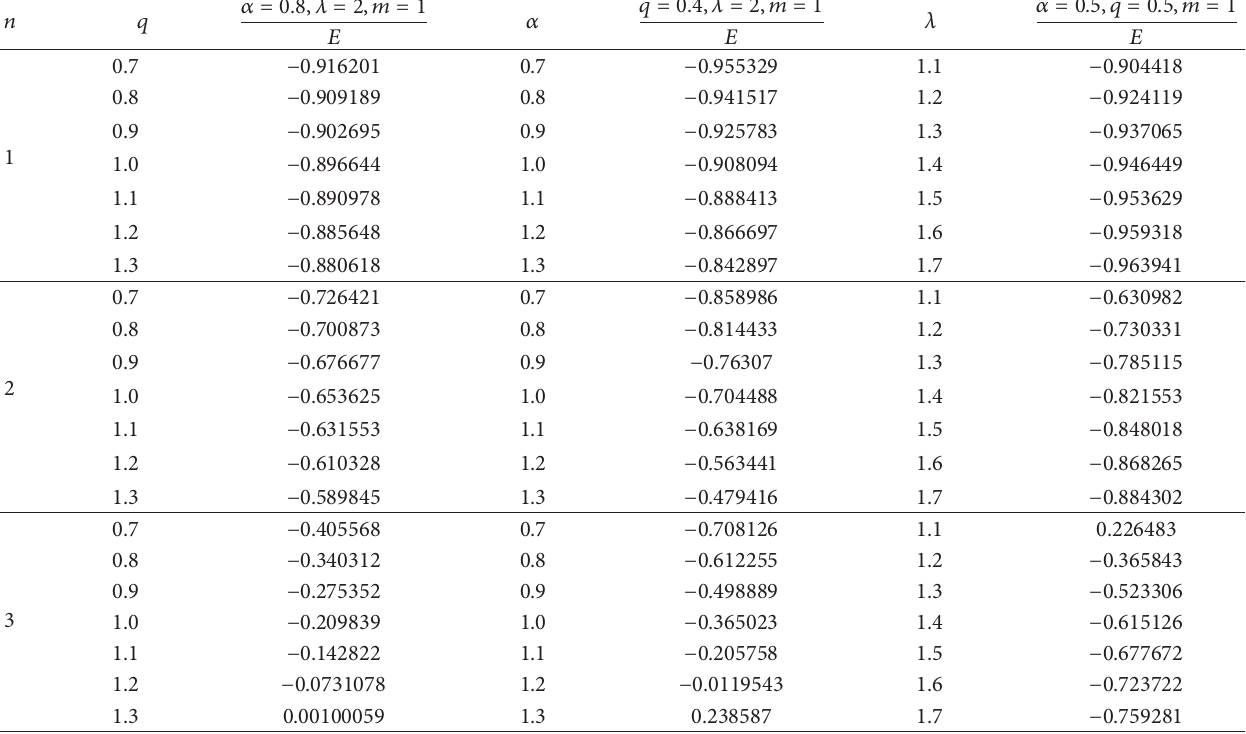
Table 2: Evaluation of numbers of the bound states for the 𝑞 HPT potential against several values of 𝛼 , 𝑞 , and 𝜆 .